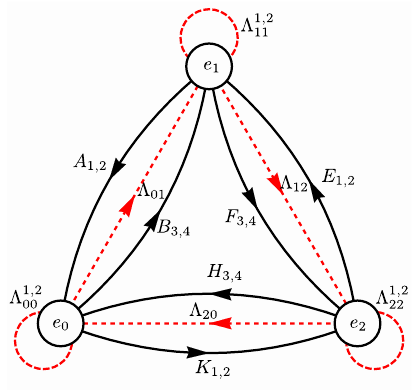
Figure 2 . The C 3 = Z 3 (1 ; 1 ; 2 ; 2) supersymmetric quiver, with all the chiral and fermi multiplets indicated